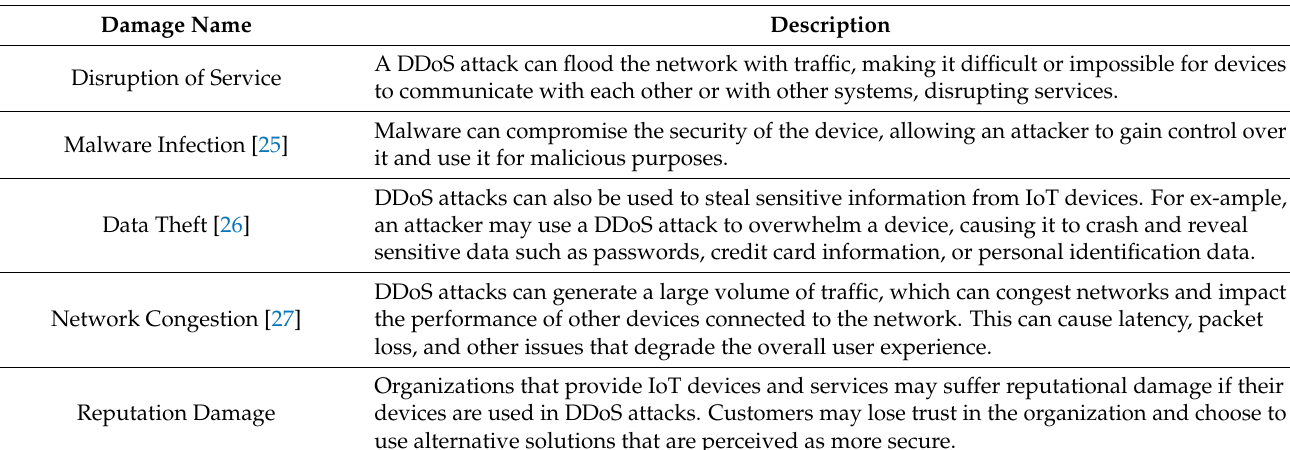
Table 1. Main potential damages of DDoS attacks on IoT.